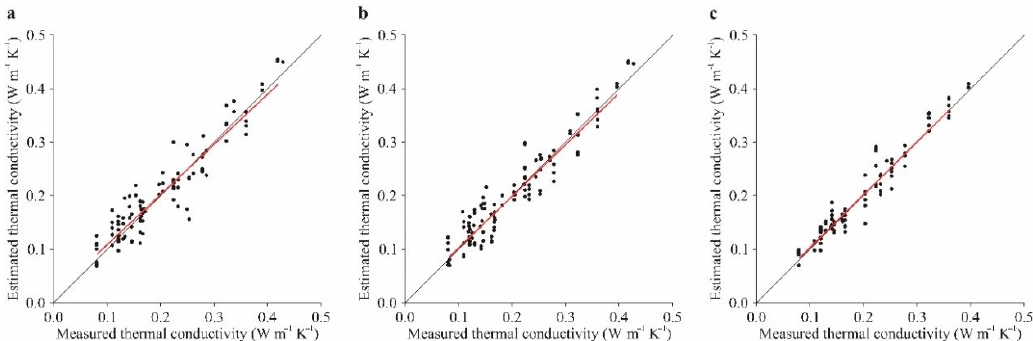
Figure 12. Estimated thermal conductivity ( k est , W m − 1 K − 1 ) of bed compost materials versus measured ( k mea , W m − 1 K − 1 ) values when applying static compaction (SC) for each depth evaluated: ( a ) H1, ( b ) H2, and ( c ) H3.